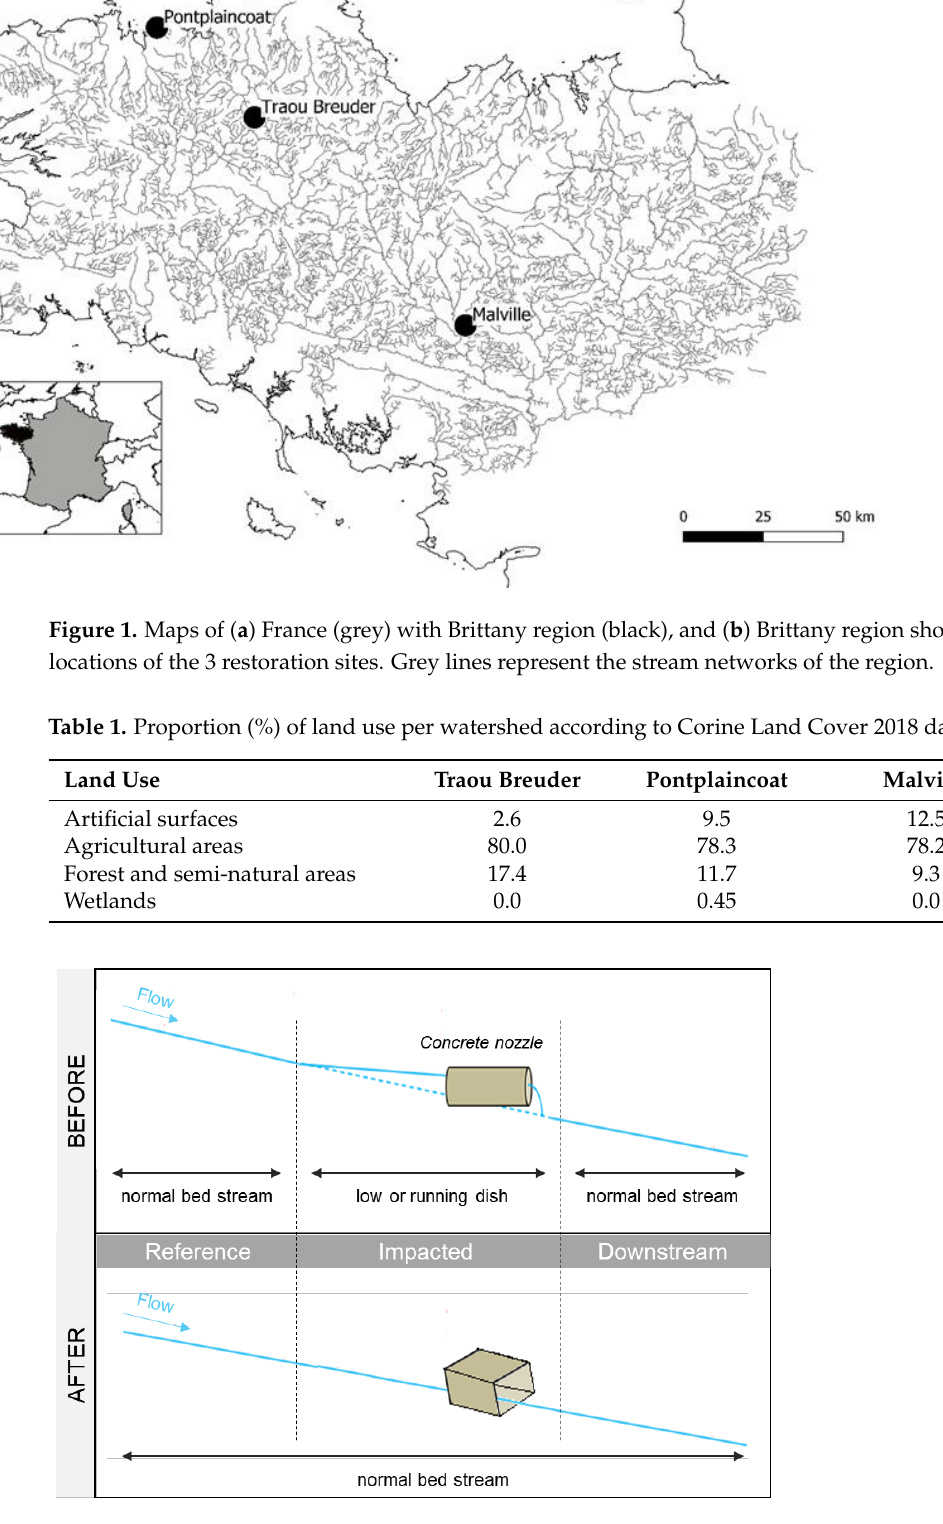
Figure 2. Channel profile before (upper part) and after (lower part) the replacement of the concrete pipe. The shaded areas delimited by dotted lines represent the three sampling sites (i.e., reference, impacted, and downstream) for each